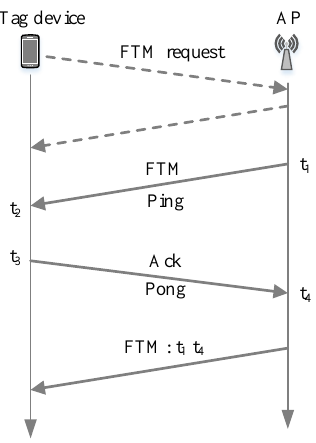
Figure 5. The fine timing measurement (FTM)